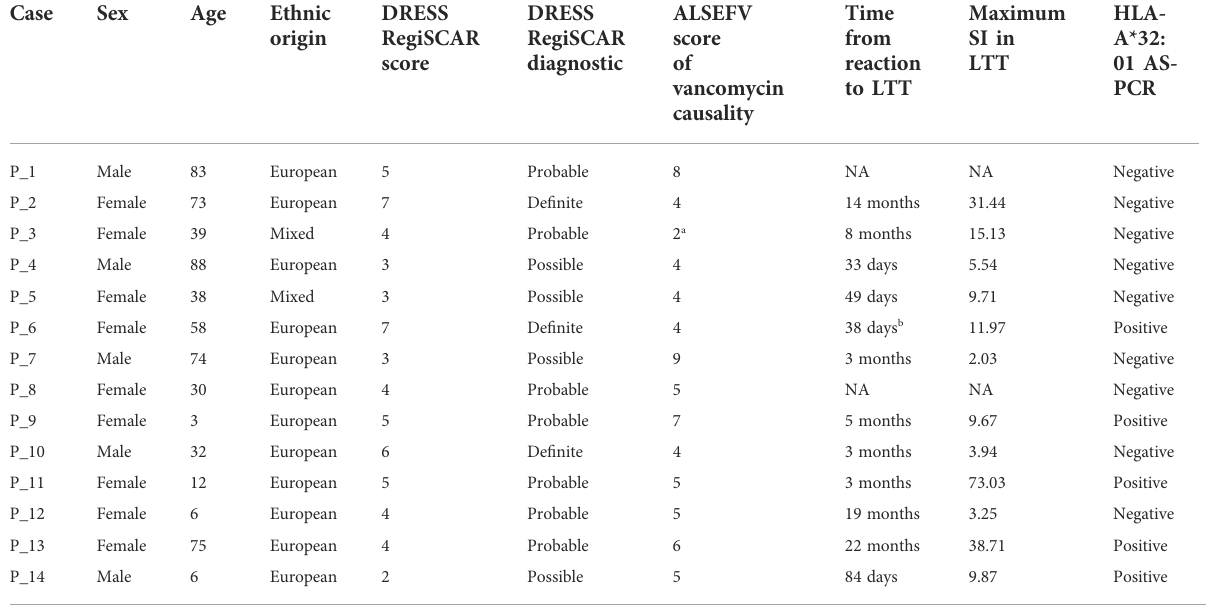
TABLE 1 Demographics and main results in DRESS